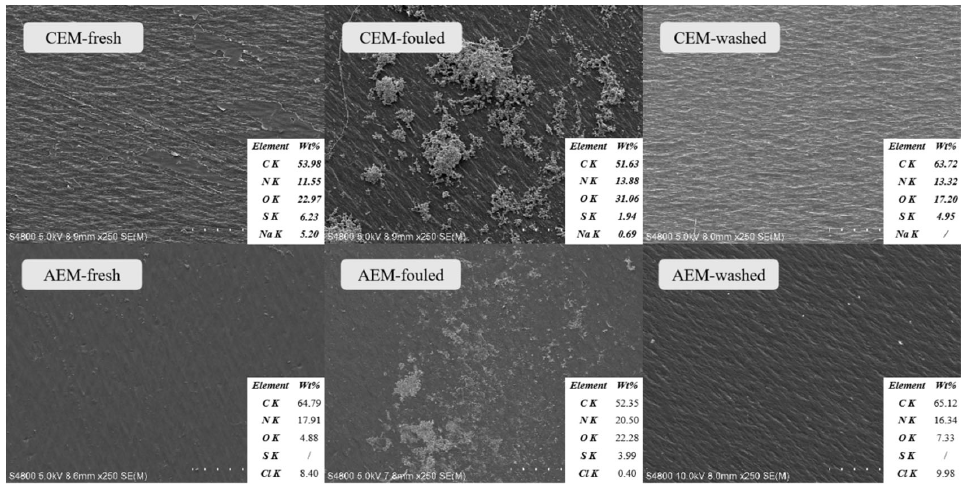
Figure 5. The SEM electron micrographs with EDS of CEM and AEM membranes in three states (fresh, fouled, and washed).